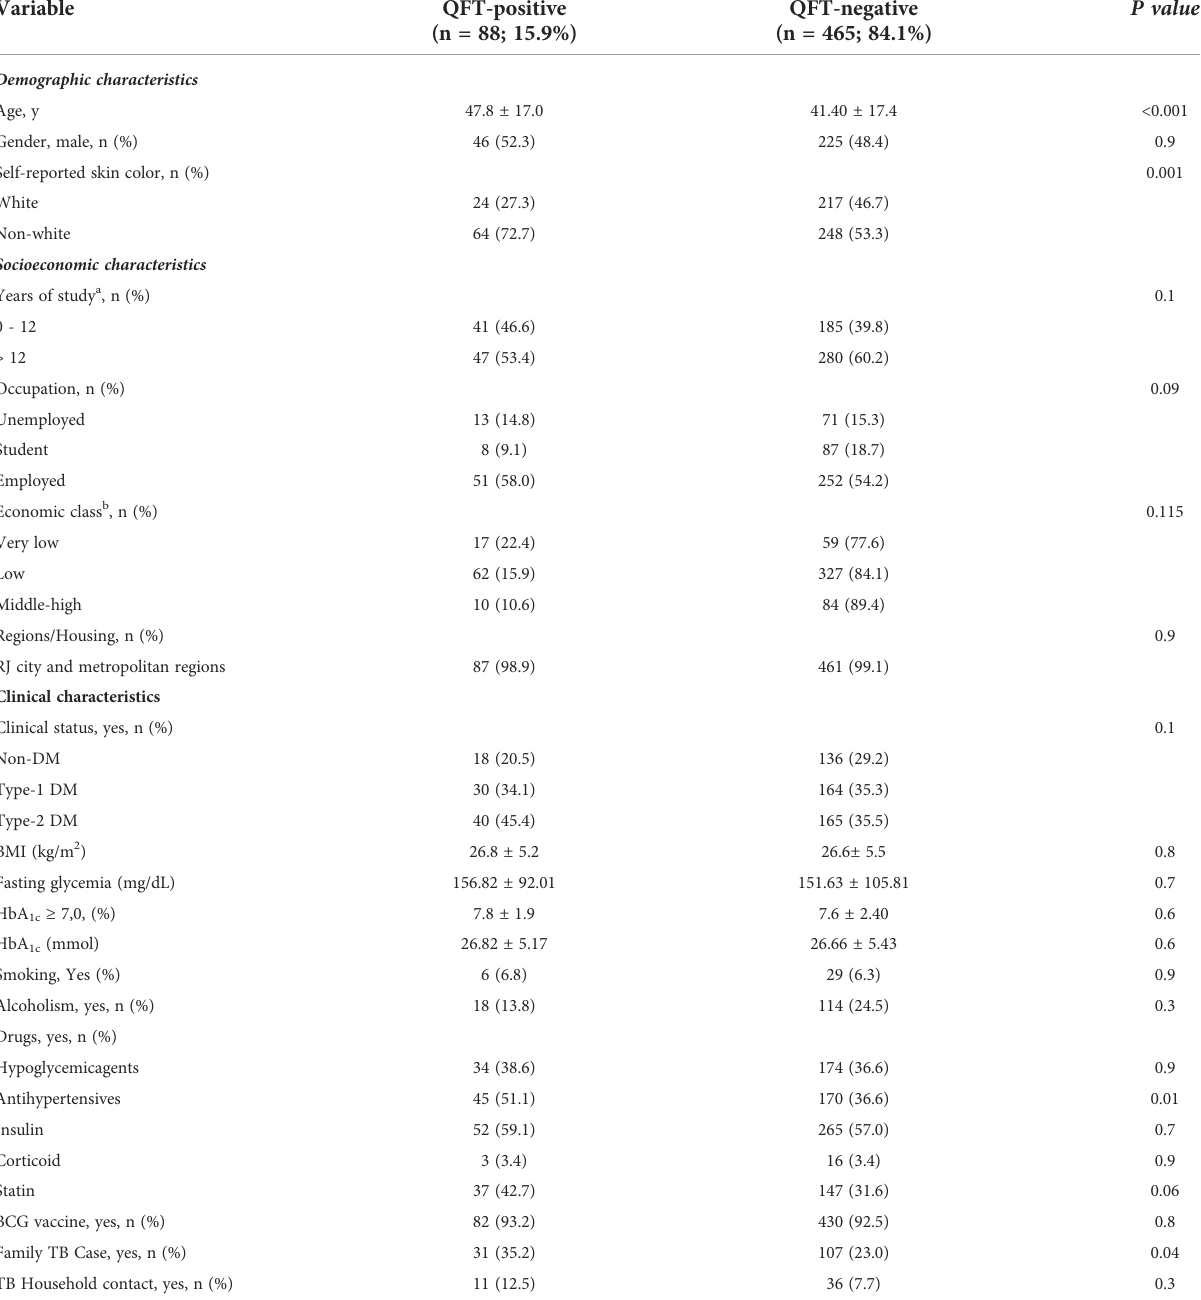
TABLE 2 Characteristics of participants with LTBI among study population. Variable QFT-positive (n = 88;